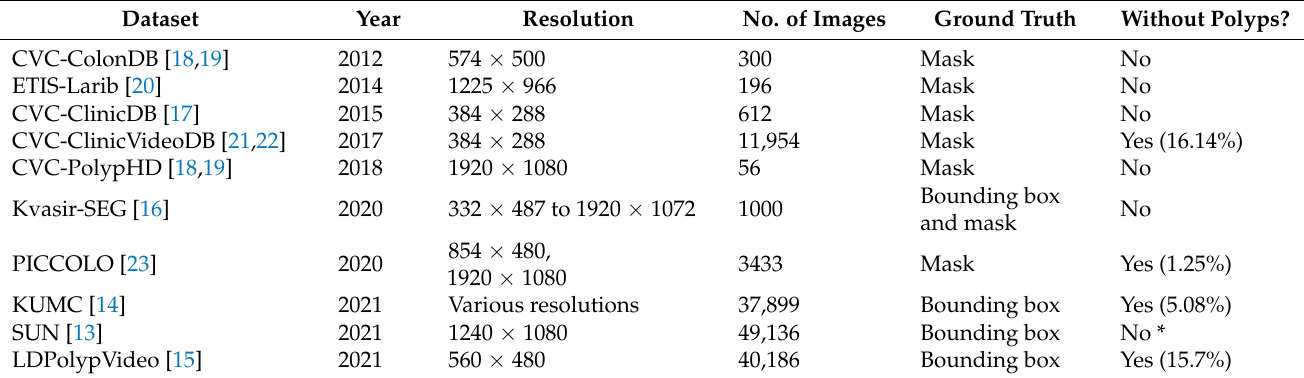
Table 1. Summary of the ten public colonoscopy image datasets for polyp location including: the name and publication/s related with the dataset (Dataset), the year when the dataset was published (Year), the image resolution (Resolution), the number of images in the dataset (No. of images), the method used to provide image location (Ground Truth), and whether the dataset includes images without polyps and the percentage of images with polyps in case they are included (Without